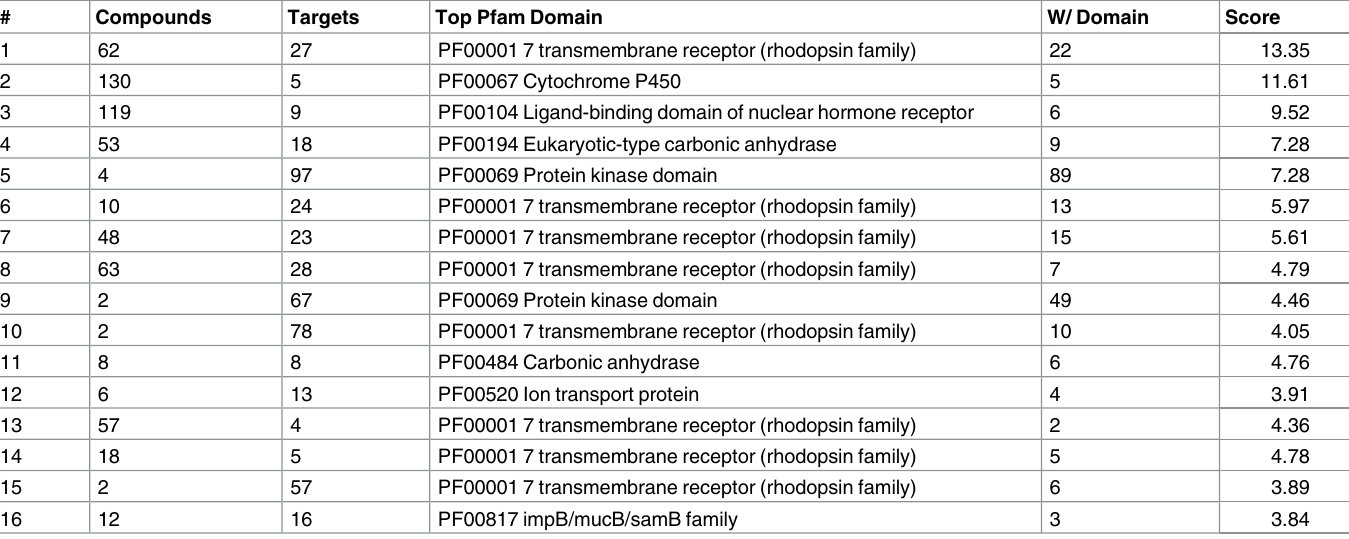
Table 7. Top pfam domains in each bicluster. Shownare the top 16 highestscoring drug-target biclusterswith more than one compound and more than one target. The number of drugs (cids) and targets is shown in columns 2 and 3, respectively. The 4th and 5th columns give the name of the most abundant domainand its frequency, respectively. The last (6th) column shows the BicBin score, representingthe density and size of the bicluster. The BicBin score is the negativeexponentof the Chernoff Bound. It is inverselyproportional to the probabilityof each bicluster occurring by randomchance, as describedin